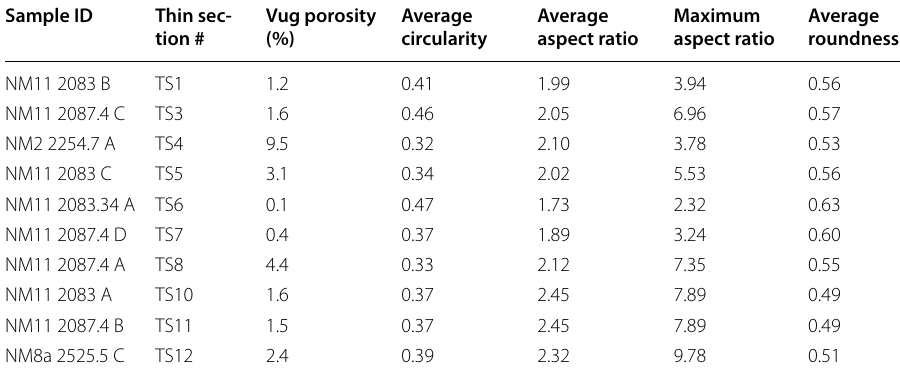
Table 2 Quantitative analysis of thin sections with vug pore space Sample